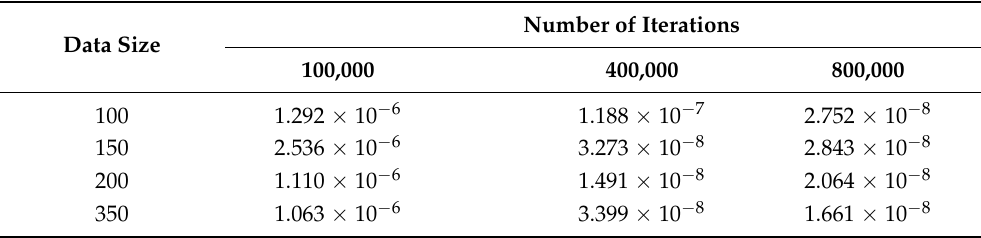
Table 5. Results of the mean square error analysis of varying number of iterations and data size per layer in the